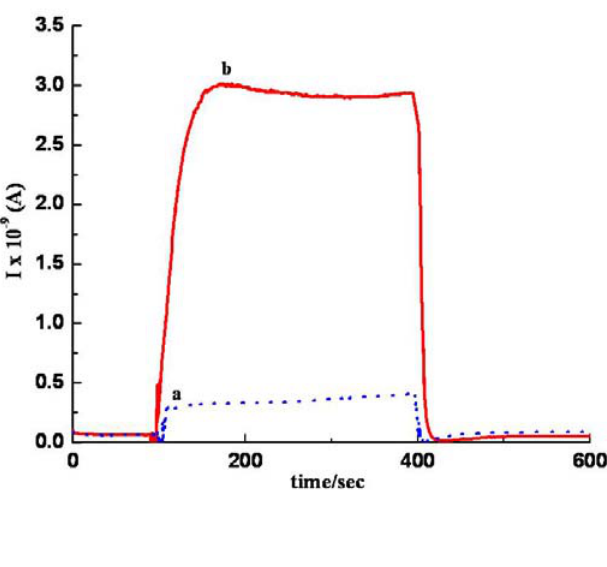
Figure 12. Response graph of (a) im MWCNTs/Nylon-6 nanofiber composite; (b) sa MWCNTs/Nylon-6 nanofiber composite during the exposure to ethanol at room